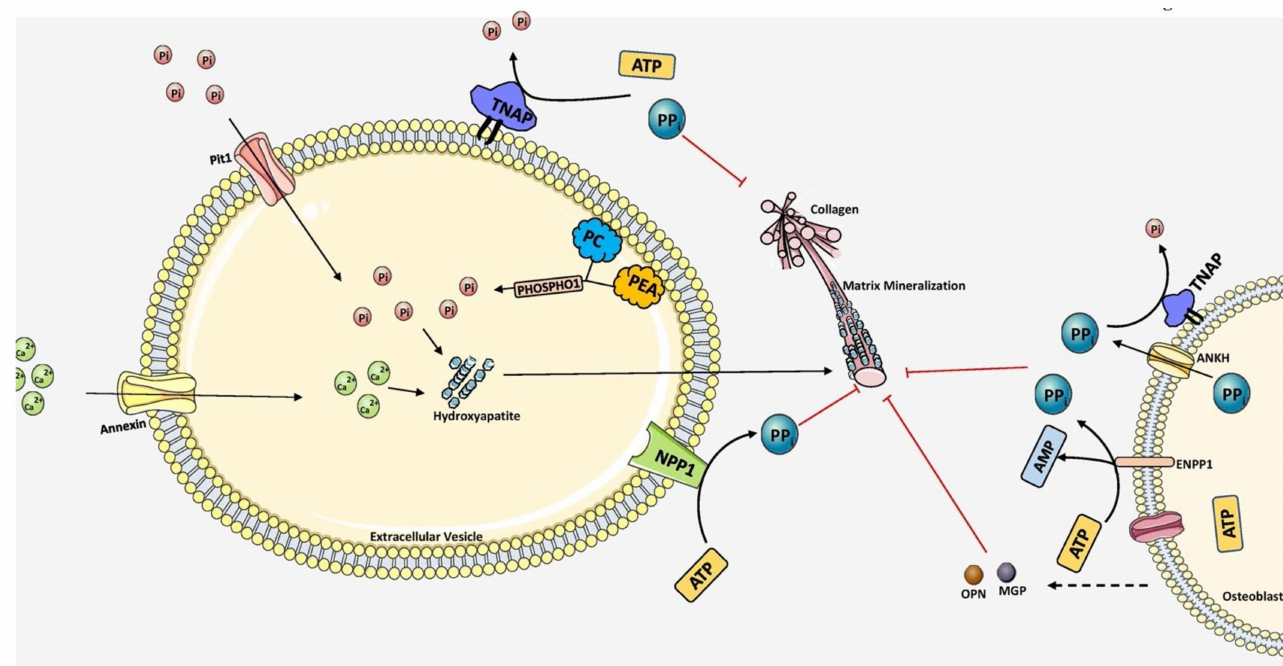
Figure 3. Overall scheme of matrix mineralization mediated by extracellular vesicles (EV) released from osteoblasts. The growth of hydroxyapatite inside EVs is mediated by the PHOSPHO1 which supplies P i by hydrolyzing PC and PEA in the plasma membrane. P i t1 transporter also pumps P i into the EVs. Calcium is transported inside by Annexin (A1, A2, A4, A5, A6, A7) channels. Together, hydroxyapatite crystals are formed inside the EV. It then penetrates through the vesicle membrane and elongates extracellularly utilizing P i and Ca 2+ ions. PP i inhibits mineralization which is produced by ATP hydrolysis mediated by NPP1. TNAP hydrolyzes PPi into P i , essential for hydroxyapatite growth. Extracellular PP i is also provided by ANKH and ENPP1 situated in the plasma membrane of osteoblasts. Mineralization is regulated tightly by maintaining the balance between PP i and P i ratio. The components in this figure were modified from Servier Medical Art, licensed under a Creative Common Attribution 3.0 Generic License. (http://smart.servier.com, accessed on 1 August